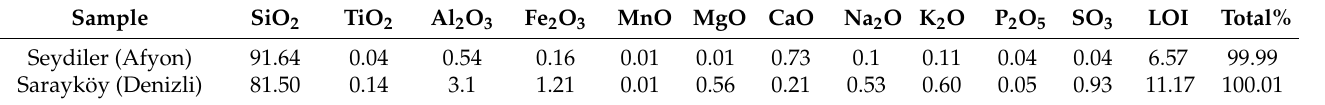
Table 1. Major element analysis of diatomite